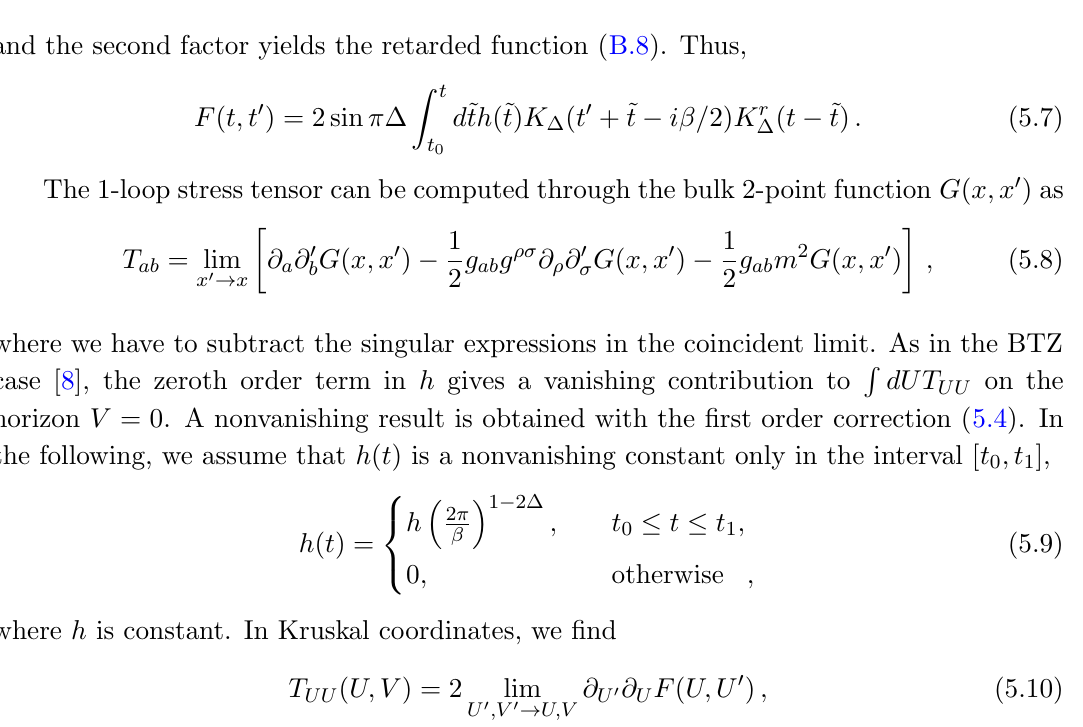
Figure 5 . The deformation (cid:14)H ( t ) is turned on at t violet-colored right wedge is the intersection of the spacelike region of the point t L = left boundary and the timelike region of the point t R = t 0 at the right